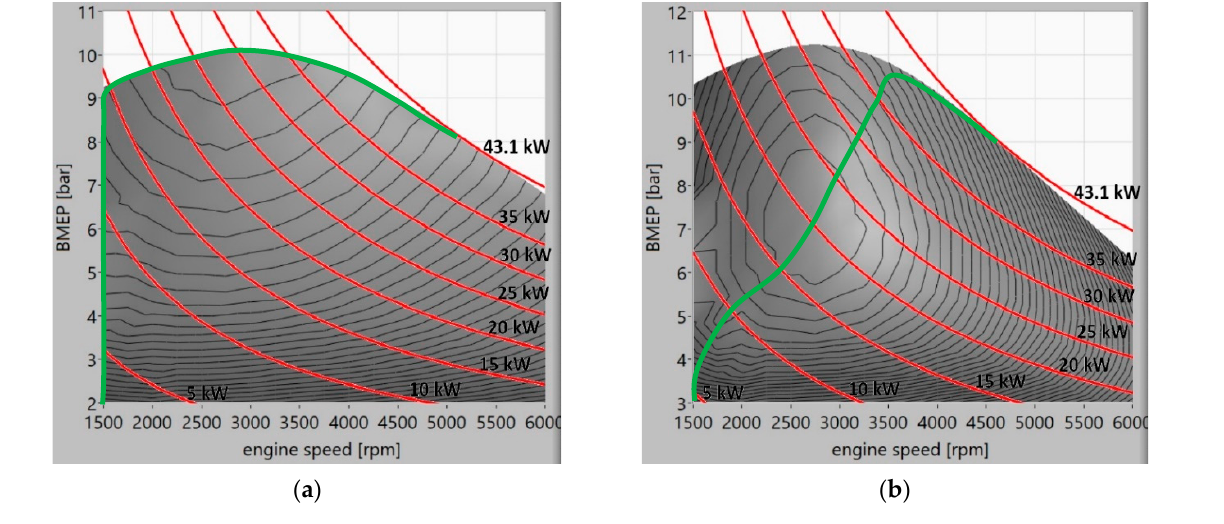
Table 3. The engine power and BTE of points lying on BEPs.